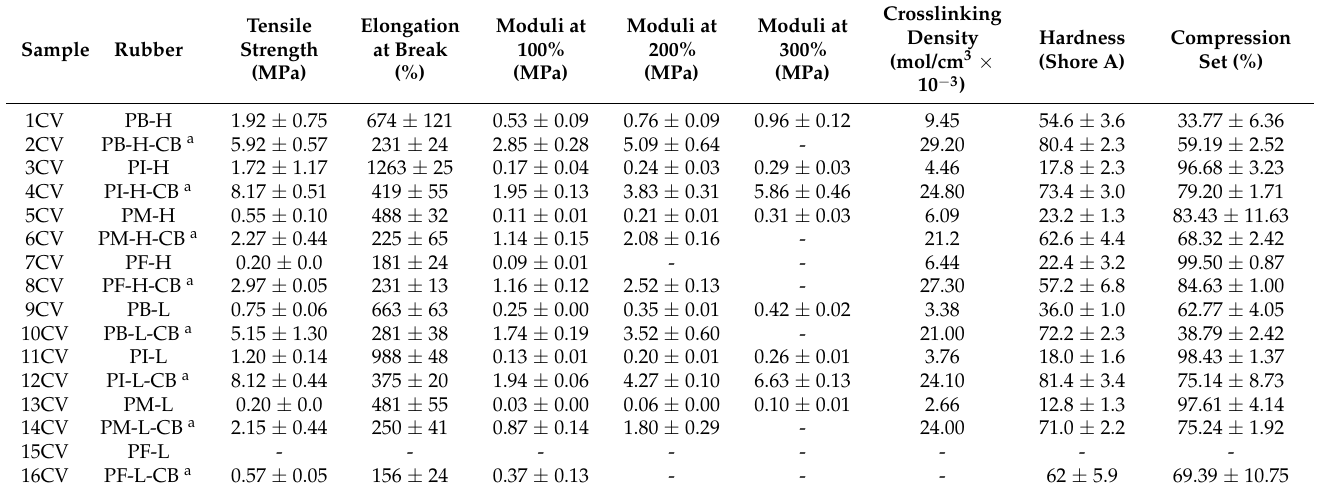
Table 3. The mean and standard deviation (mean ± SD) of the mechanical properties and crosslinking density of rubbers with the CV system.